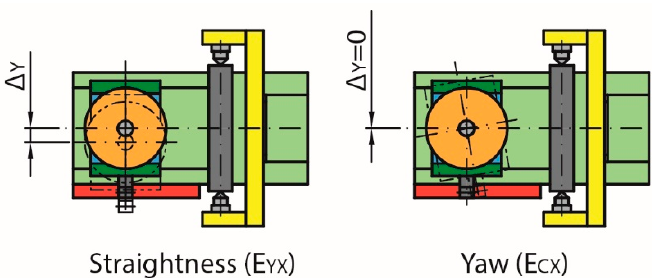
Figure 8. Non-compensated errors (Y-axis) due to movement along the X-axis.